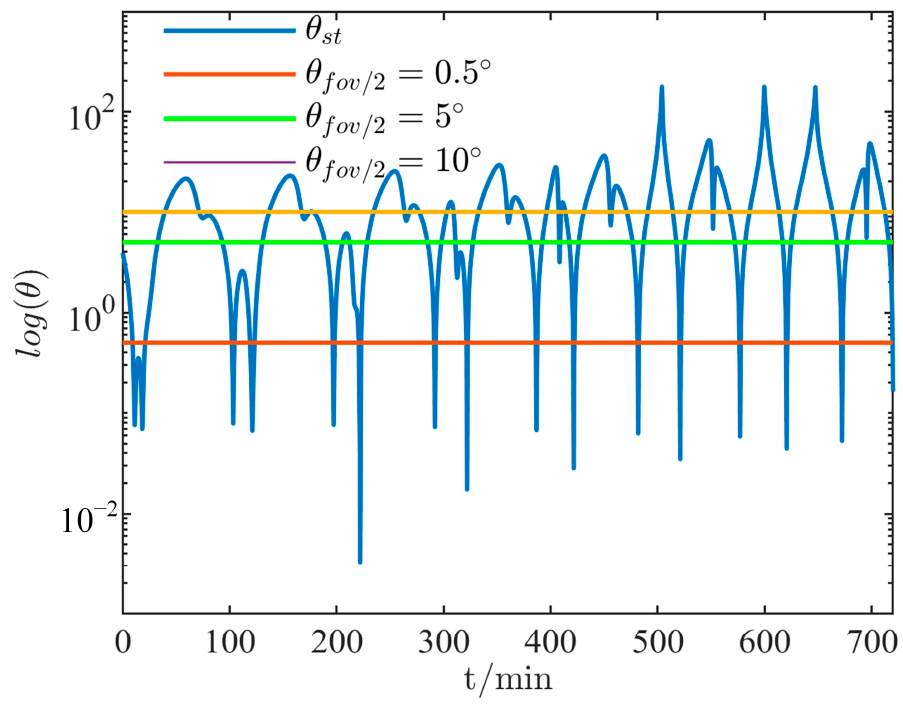
Figure 10. The simulated observation arcs of the RSO in the STM